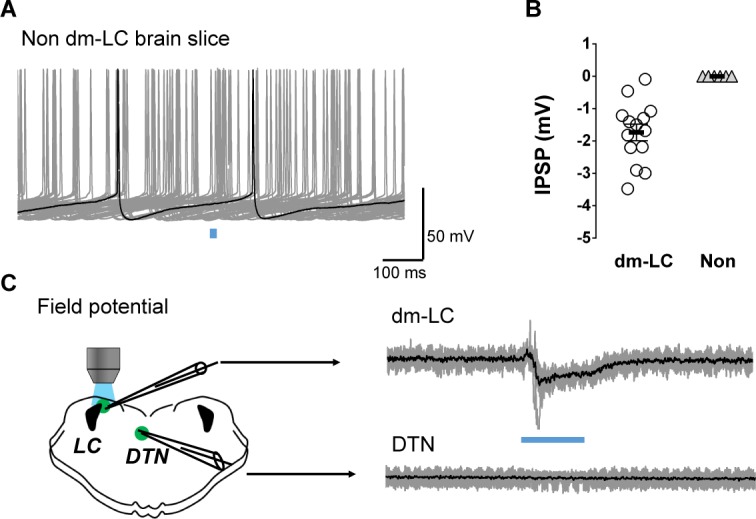
(A) In the brain slices without dmLC GABAergic neurons, 10 ms blue light pulse failed to elicit IPSP in LC neurons. (B) Quantification of GABAergic IPSPs in LC neurons of dmLC (circle, n = 14 cells of 6 slices) and non dmLC brain (triangle, n = 9 cells of 5 slices) slices. (C) Blue light (50 ms) evoked field potentials when the extracellular recording electrode was positioned in the dmLC but not in the DTN.